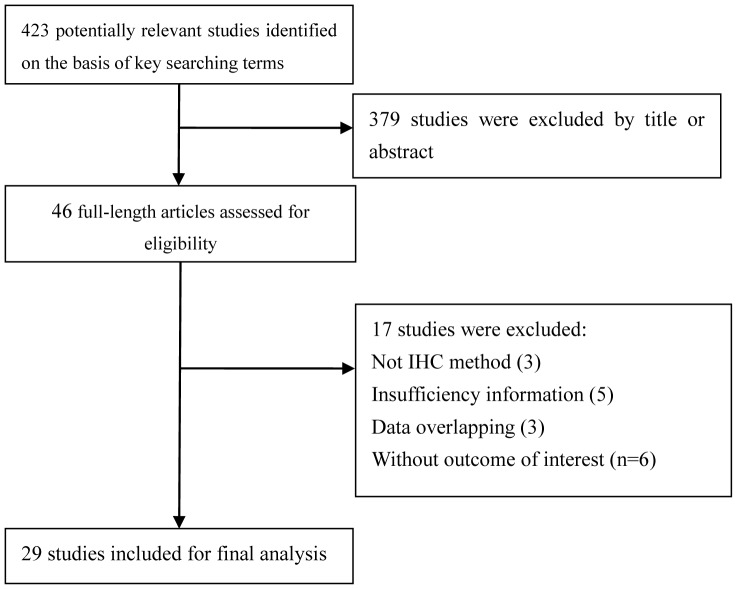
Flow diagram of studies selection procedure.